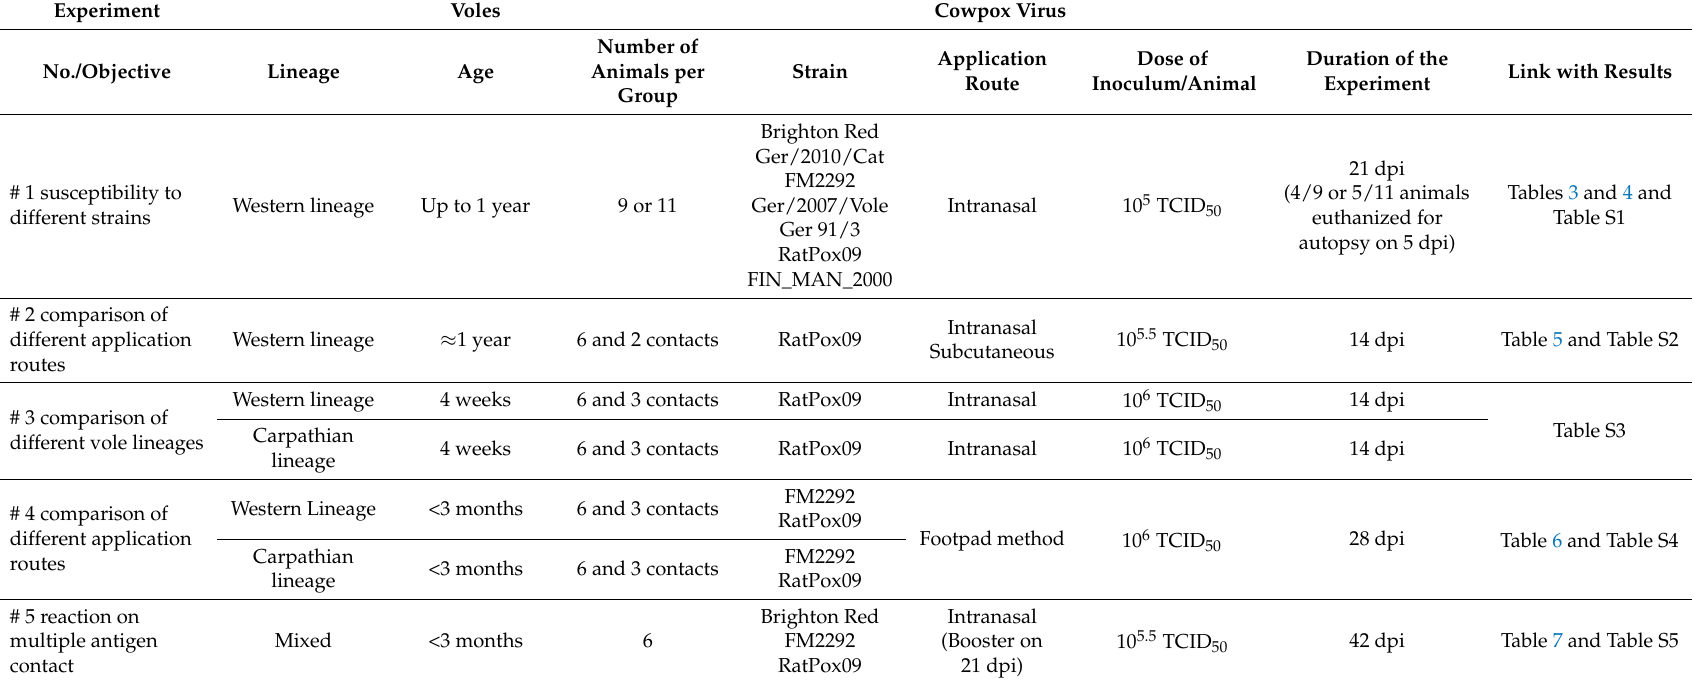
Table 2. Design of the animal